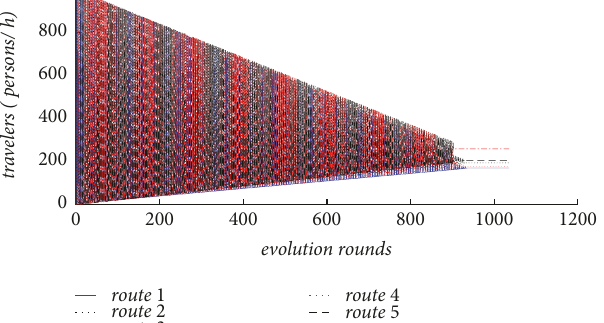
Figure 3: Volume evolution of five routes for 𝑞 = 1000 , 𝛼 = 0.3 , = 0.2 , 𝜃 = 0.2 . Δ 𝑖 𝑖